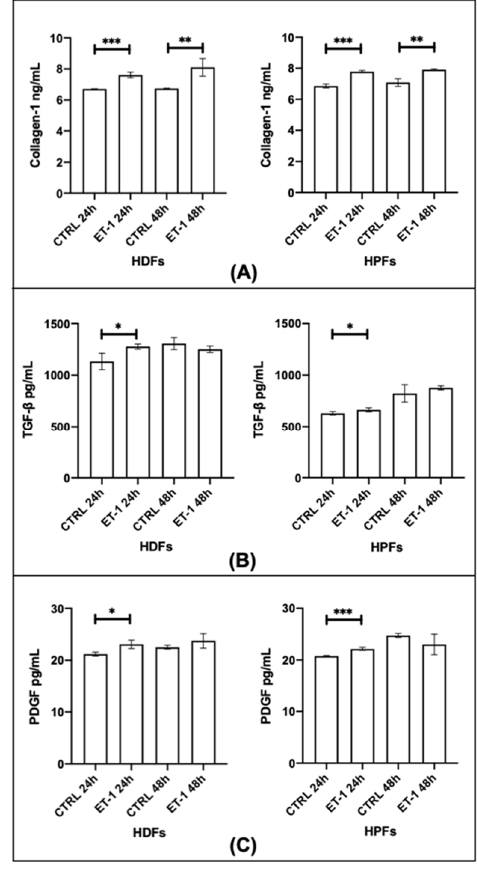
Figure 4. Fibroblast activation after ET ‐ 1 stimulation. The activation of fibroblasts was analyzed measuring levels of ( A ) collagen ‐ 1 reported in ng/mL, ( B ) TGF ‐β reported in pg/mL, and ( C ) PDGF reported in pg/mL in supernatants of HPFs and HDFs after 24 or 48 h of incubation with ET ‐ 1. A stimulation of 24 h was sufficient to induce the production of collagen ‐ 1, TGF ‐β , and PDGF in HPFs and HDFs. After 48 h, collagen ‐ 1 was released by HPF and HDF supernatants. (*** p < 0.0005; ** p < 0.005; * p < 0.05). (HPFs: human pulmonary fibroblasts; HDFs: human dermal fibroblasts; ET ‐ 1: endothelin ‐ 1; TGF ‐ β : transforming growth factor ‐β ; PDGF: platelet ‐ derived growth factor).